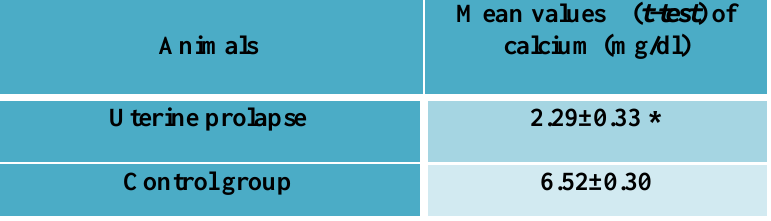
Table, 1: Values of calcium serum levels (mg/dl) in uterine prolapse and control ewes